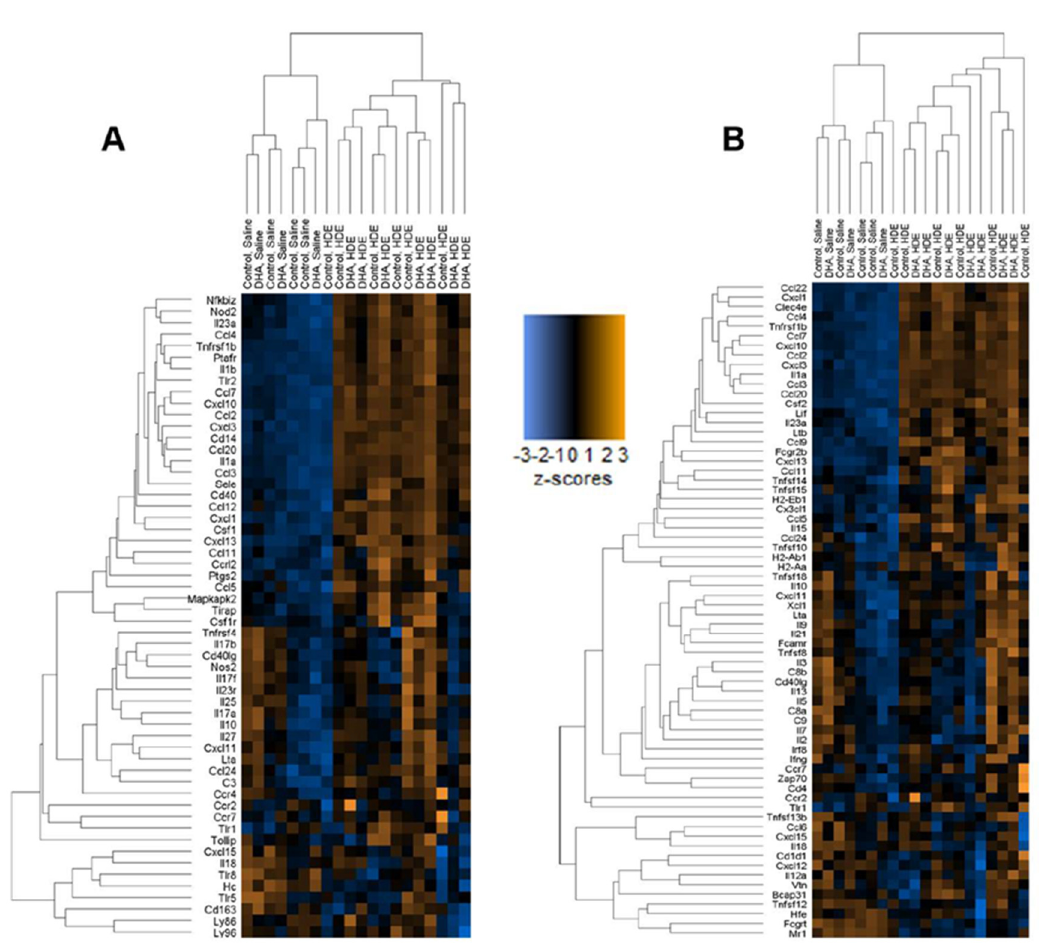
Figure 8. Hierarchal clustering shown by heat maps related to inflammation for all 20 normalized samples. ( A ) Heat map showing clustering of genes related to the inflammatory response. ( B ) Immune response heat map showing altered genes among all 20 samples.